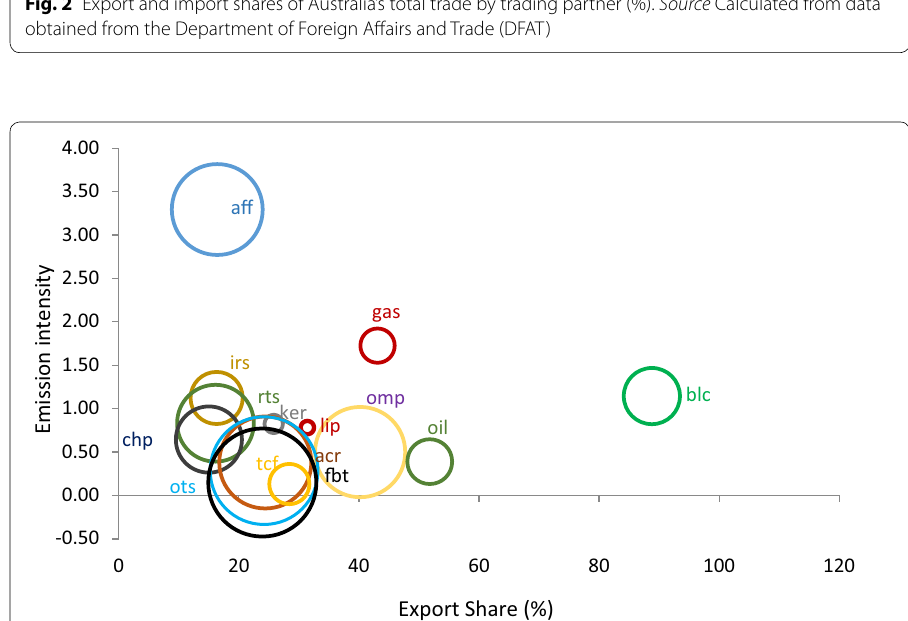
Fig. 3 Emissions intensity and export exposure of sectors. Note Size of bubble represents output. Source Calculated from data obtained from DCCEE, DFAT and